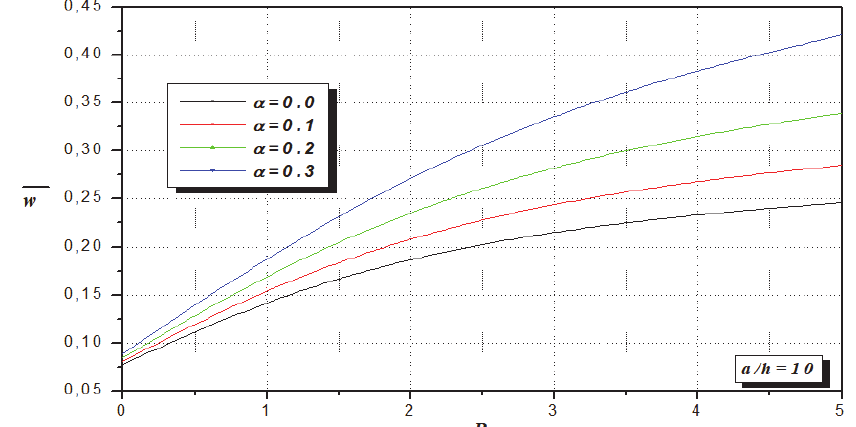
Figure 4: Displacement variation w as a function of the power index P and the different porosity factor α of sandwich plate FGM